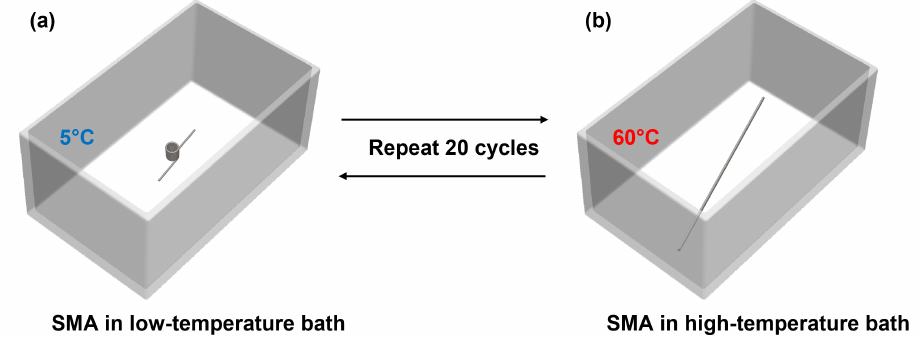
Figure 4. Thermo-mechanical training of the two-way SMA. ( a ) SMA is in low-temperature bath for training. ( b ) SMA is in high-temperature bath for